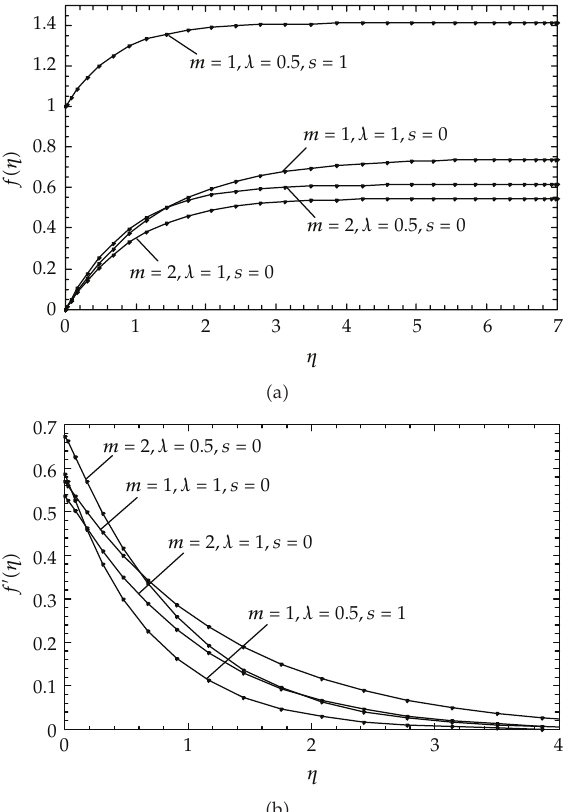
Figure 1: ChPDM solutions (cid:3) solid line (cid:4) and homotopy analysis method (cid:3) circles (cid:4) (cid:5) 11 (cid:6) for (cid:3) a (cid:4) f (cid:3) η (cid:4) and (cid:3) b (cid:4) f (cid:2) (cid:3) η (cid:4) for various values of the investigated